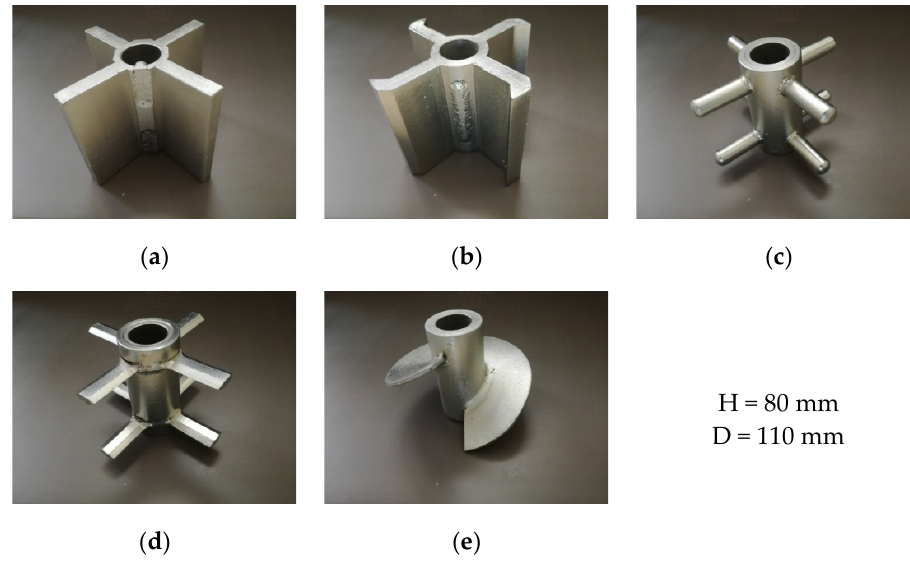
Figure 2. Rotors used in experiments. ( a ) Vane rotor, ( b ) sharp vane rotor, ( c ) rod rotor, ( d ) knife rotor, ( e ) screw rotor.